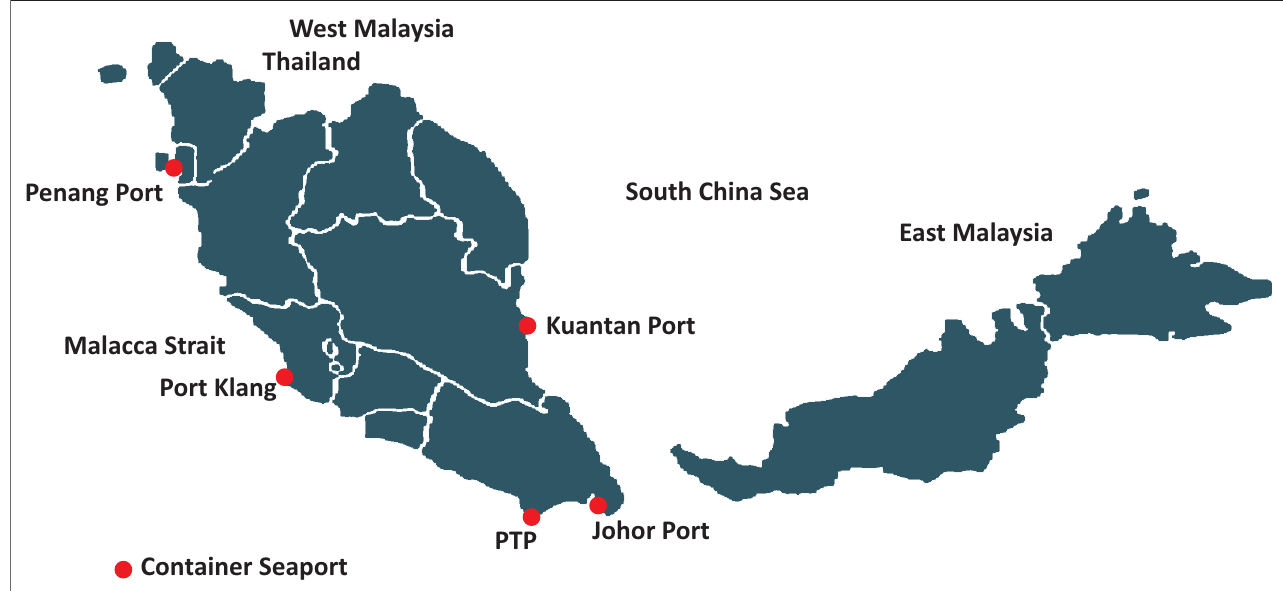
ThailandWest Malaysia